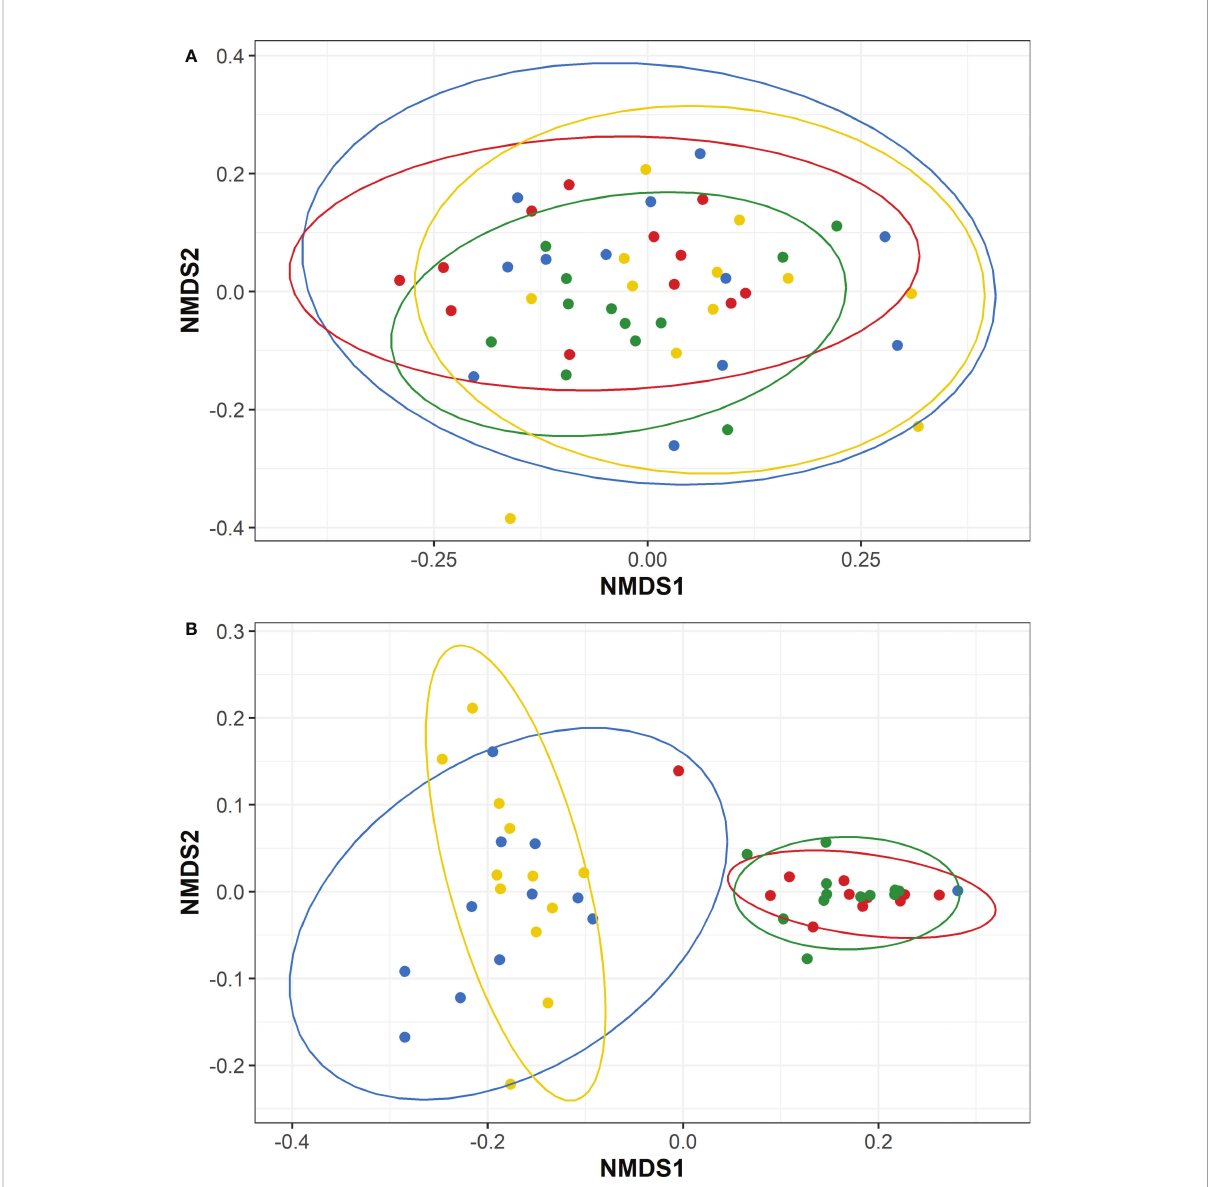
FIGURE 6 Non-metric Multidimensional Scaling (NMDS) plots representing the T3 beta diversities between steelhead trout fed different concentrations of a probiotic. Distances were calculated by (A) unweighted UniFrac and (B) weighted UniFrac between four diets: A (colored blue), B (colored red), C (colored green), and (colored yellow). Ellipses represent the 95% con fi dence intervals calculated via Student ’ s T test for 12 T3 intestinal